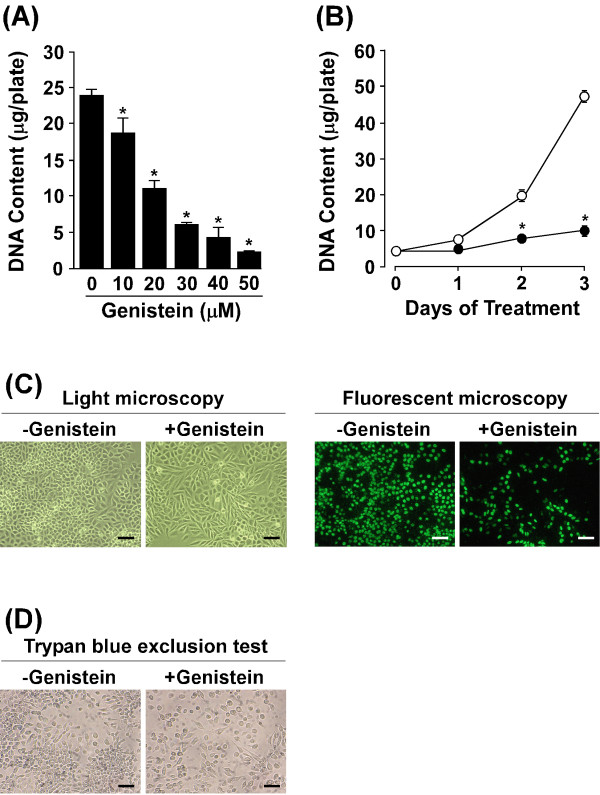
Effect of genistein on cell proliferation and DNAreplication. (A) LM8 cells were treated for 3 days with 0–50 μM genistein, and the DNA content of the cultures was measured. *p < 0.01 (compared with the values for the untreated cultures). (B) LM8 cells were treated without (open circle) or with (filled circle) 50 μM genistein, the DNA content of the cultures was measured at the indicated intervals. *p < 0.01 (compared with the values for the untreated cultures). (C) LM8 cells were treated for 3 days without (left panel) or with (right panel) 50 μM genistein, and immunofluorescence staining of BrdU incorporated into DNA was performed. Both set of images are of the same field of view. Scale bar: 50 μm. (D) LM8 cells were treated for 3 days without (left panel) or with (right panel) 50 μM genistein and stained with trypan blue. Scale bar: 50 μm.